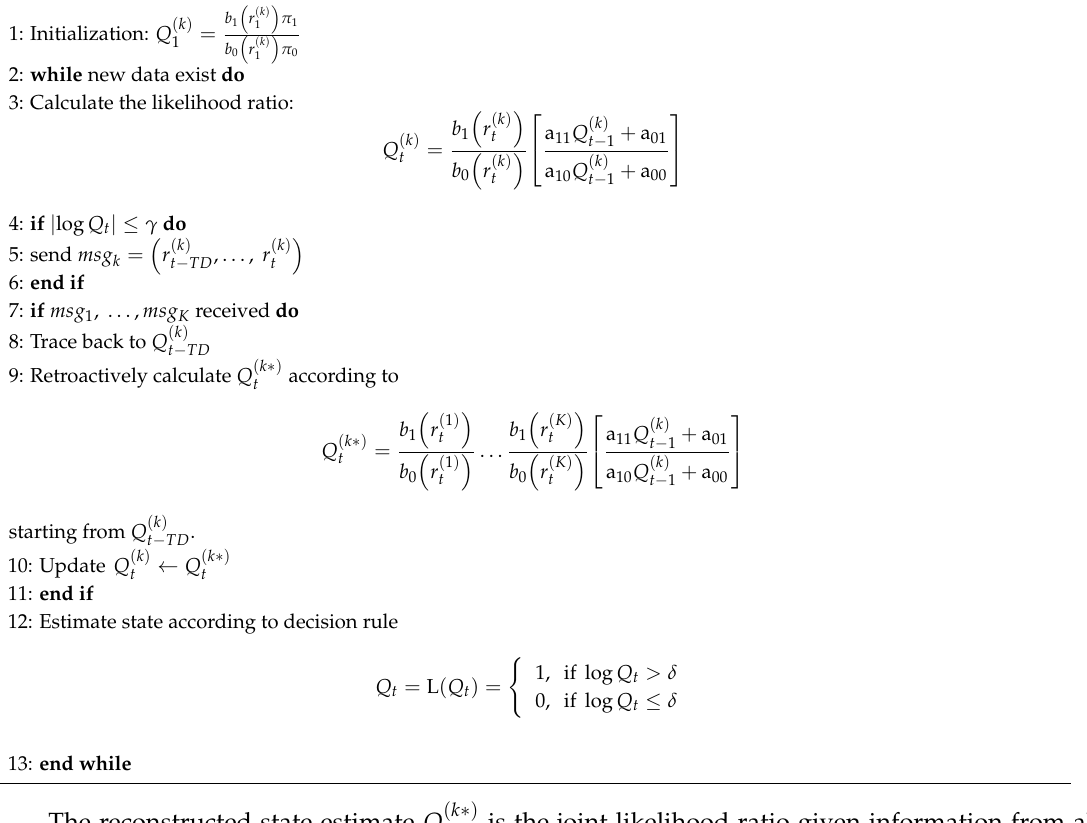
Algorithm 1: Distributed hidden Markov model (HMM) Algorithm with Sub-Optimal Retroactive